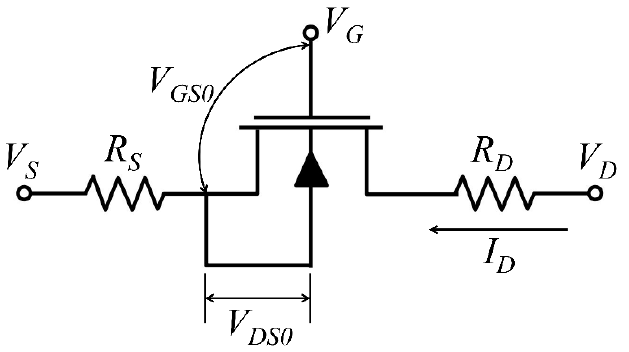
Figure 3. Equivalent circuit consisting of source and drain resistance for modeling GaN-HEMT.